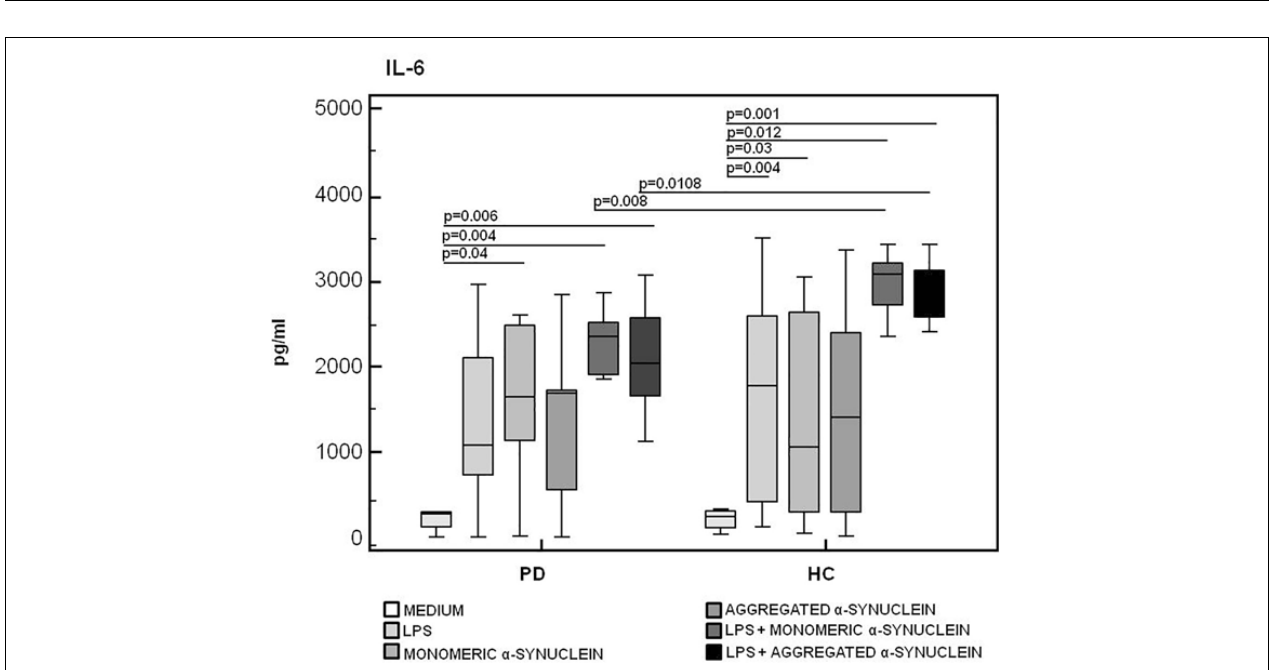
FIGURE 7 | IL-6 proinflammatory cytokine production by monomeric or aggregated α - synuclein–stimulated cells of PD and HC subjects. IL- β was quantified by enzyme-linked immunosorbent assay in supernatants of Parkinson disease (PD, n = 15) and healthy controls (HC, n = 15). PBMCs stimulated as follows: unstimulated, LPS-stimulated, monomeric α -synuclein–stimulated, aggregated α -synuclein–stimulated, LPS-primed and monomeric α -synuclein–stimulated, or LPS-primed and aggregated α -synuclein–stimulated. Summary results are shown in the bar graphs. The boxes stretch from the 25th to the 75th percentile; the line across the boxes indicates the median values; the lines stretching from the boxes indicate extreme